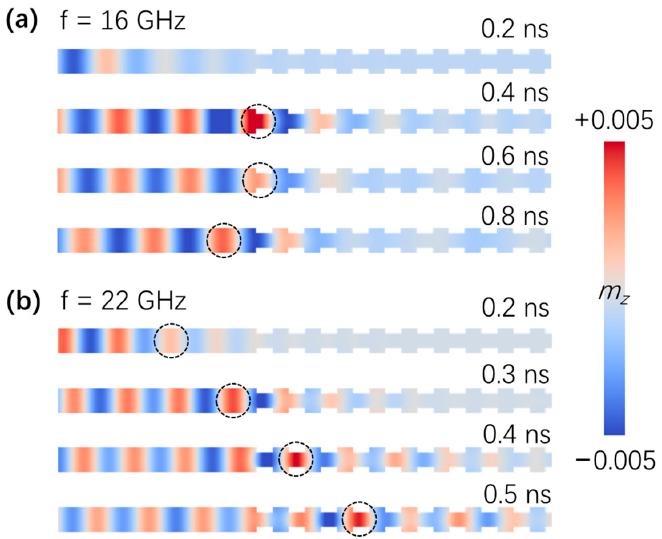
Figure 4. ( a ) Spin-wave propagation along the width-modulated nanostrip magnonic-crystal waveguide without electric field. The spin waves were excited using a sine field h = h 0 sin(2 π ft) e y locally in the region x ≤ 3 nm, with h 0 = 10,000 A/m and frequency f = 16 GHz. The dashed circles are shown to guide the eyes. The spin waves could not pass through the narrow part with width modulations. ( b ) As a comparison, the frequency of the excitation field f = 22 GHz was plotted. Clearly, the spin waves propagated even in the presence of width modulations, as the red area moved towards the right with time. A linear color map is used in plotting the m z .